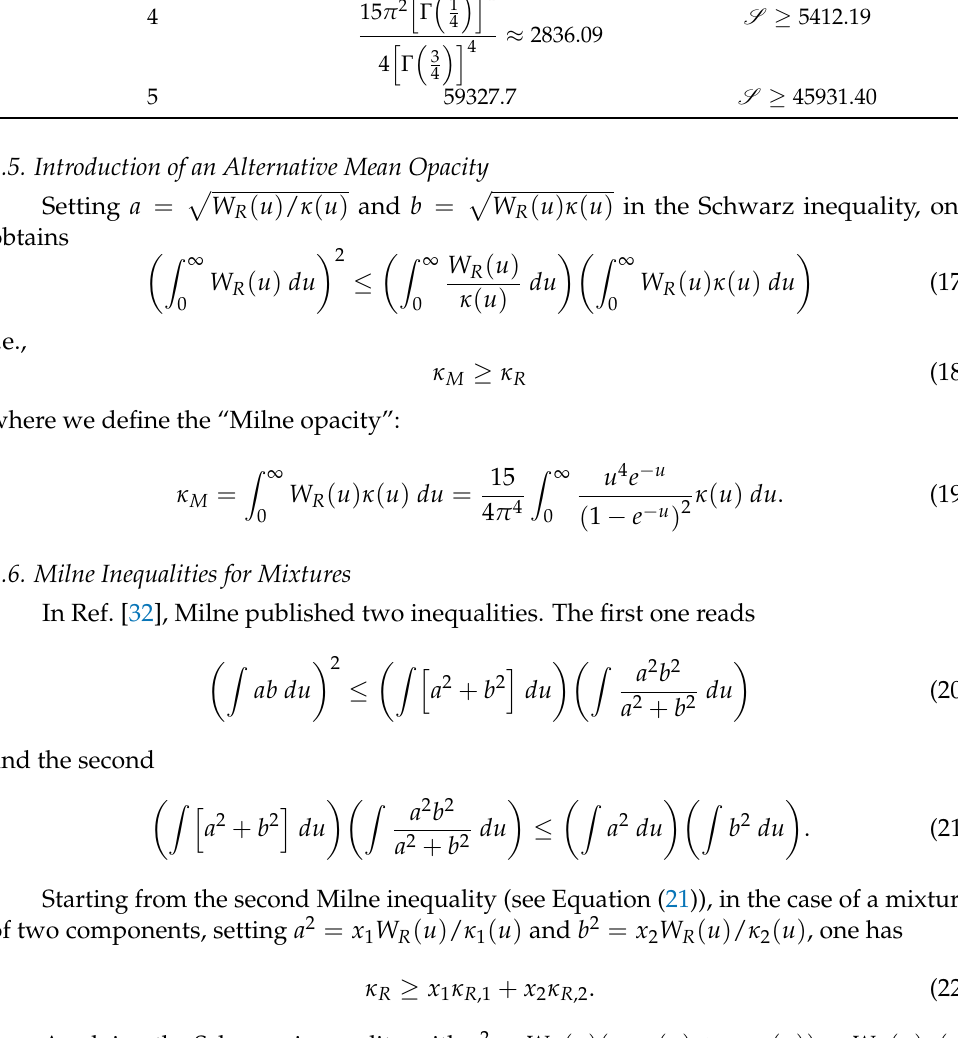
p ∞ [ W R ( u )] 1/ p du for p = 2, 3, 4, and 5. Values of K p and the lower 0 (cid:16) (cid:82) (cid:17)